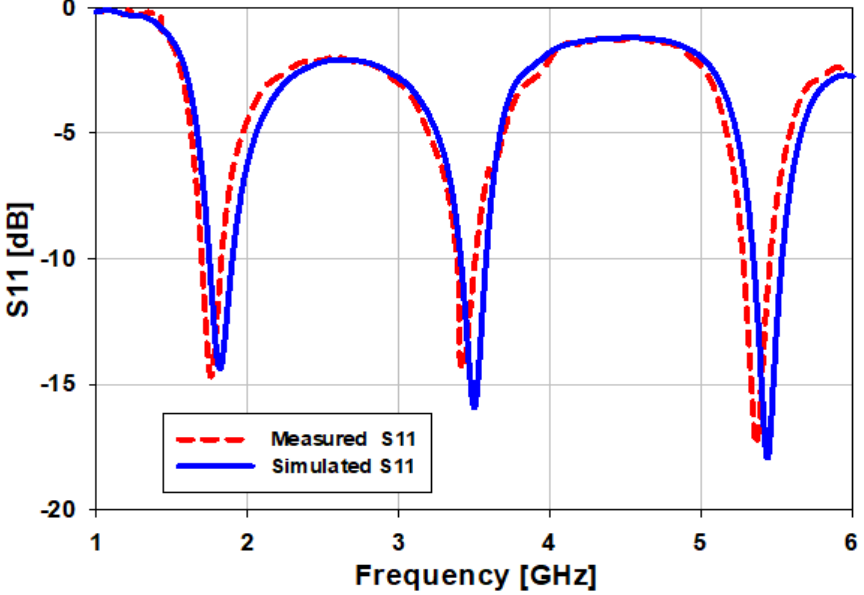
Figure 8. Simulated and measured return losses of the proposed antenna at three operating frequen-